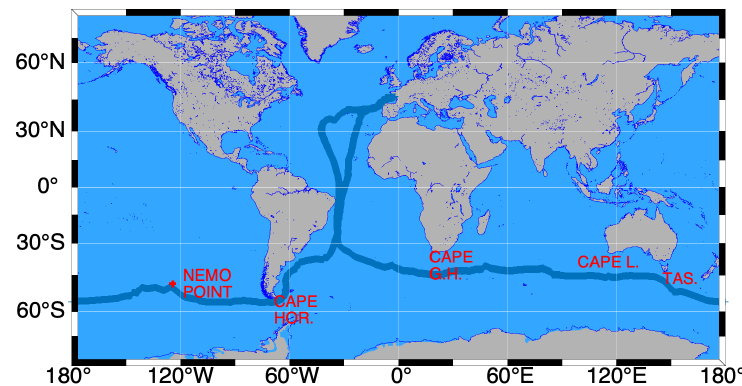
Figure 2. One Planet One Ocean trajectory during the 9th edition of Vendée Globe race. In red: TAS: Tasmania, CAPE G.H: Cape of Good Hope, CAPE HOR: Cape of Hornos, CAPE L.: Cape of Leeuwin, and the Nemo Point (124.39 ◦ W, 48.87 ◦ S) is indicated with a red cross.